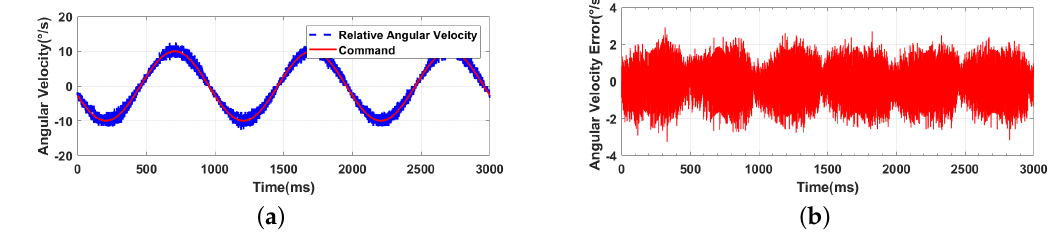
Figure 13. Group E: Controller u c + u o + u f with a light base support. ( a ) Sine command and relative angular velocity; ( b ) Relative angular velocity error.